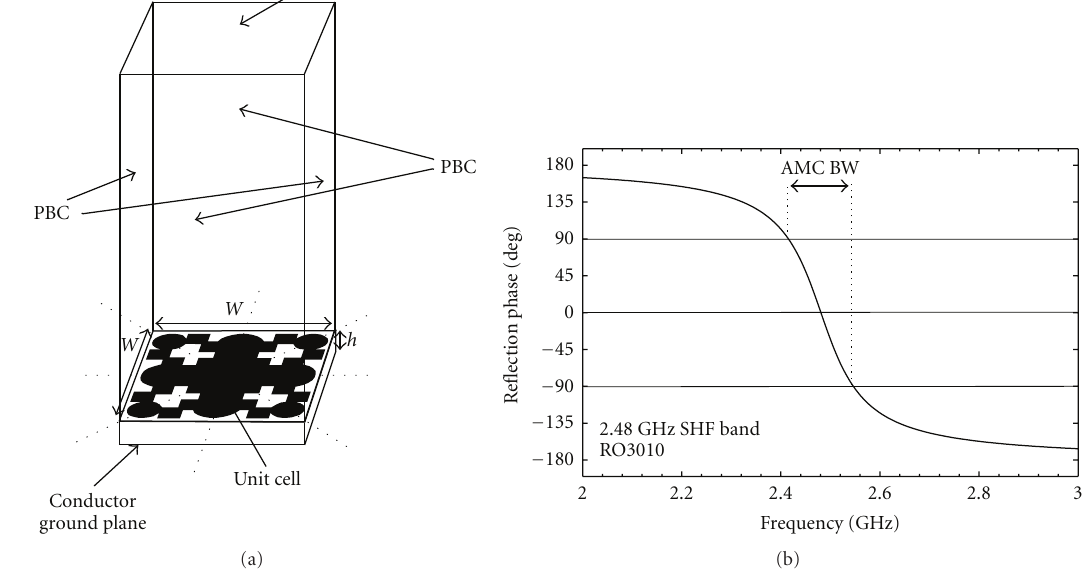
Figure 2: AMC unit cell: (a) reflection phase simulation setup, (b) phase of the reflection coe ffi cient on the AMC surface.